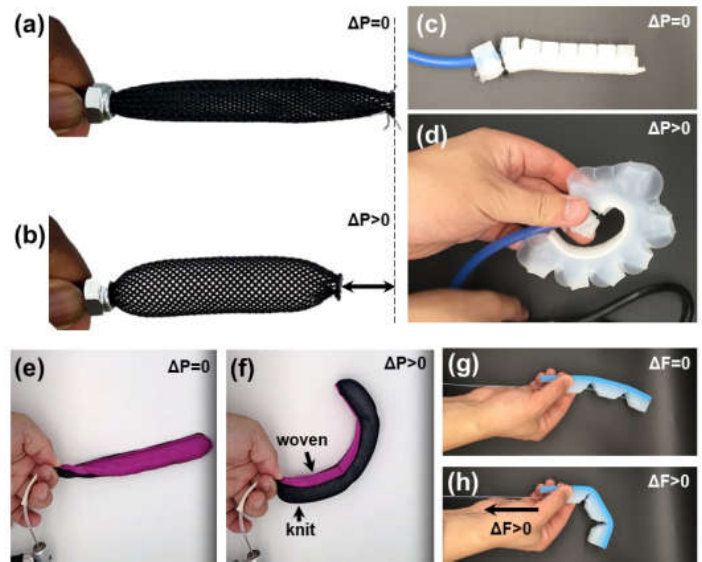
Figure 3. Examples of soft robotic actuators. ( a ) McKibbens style actuator relaxed, and ( b ) con- tracted by air powered shortening. ( c ) FEA style actuator built according to the protocol reported in Greer et al. [33] and ( d ) curled with air pressure. ( e ) Textile actuators curl based on textile weave [33]. ( f ) The restrictive weave of the pink fabric causes the actuator to curl toward woven fabric while the knit is extensible and allows for expansion. ( g ) Tendon actuated finger ( h ) curls toward